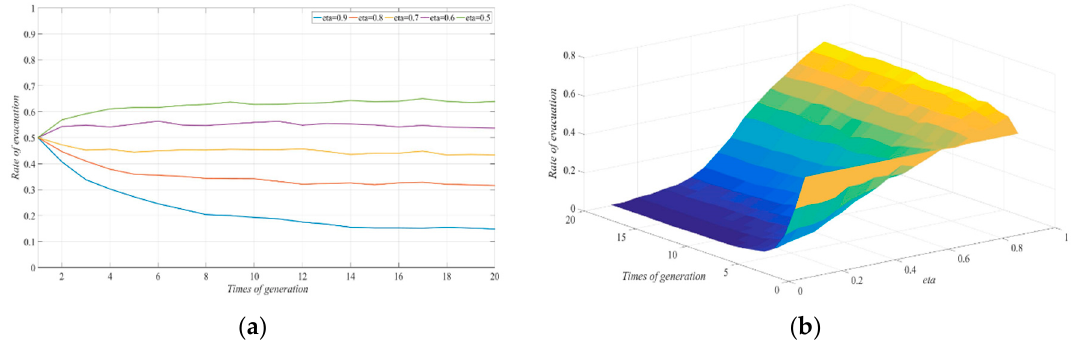
Figure 5. Effect of changes in η on the evolution of evacuation systems: ( a ) two-dimension; ( b ) three-dimension.